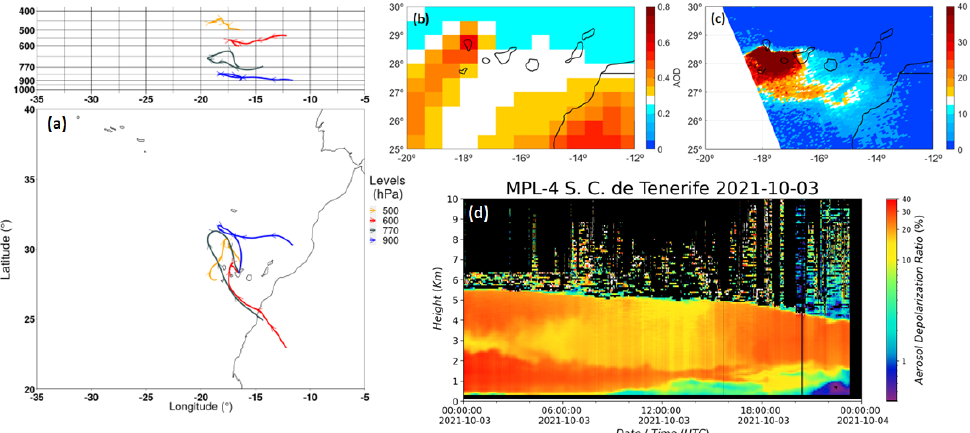
Figure 4. Backward minus trajectories (72 h), ending point at the IZO at 12:00 UTC from FLEXTRA using ERA5 reanalysis at four pressure levels (900 (blue line), 770 (black line), 600 (red line), and 500 (orange line) hPa). ( b ) Daily average MERRA-2 AOD at 550 nm on 3 October 2021. ( c ) Satellite SO 2 total columns from Copernicus Sentinel-5P TROPOMI over the Canary Islands on 3 October 2021. ( d ) Aerosol depolarisation ratio ( δ aer ) determined from the MPL at 532 nm at the SCO.